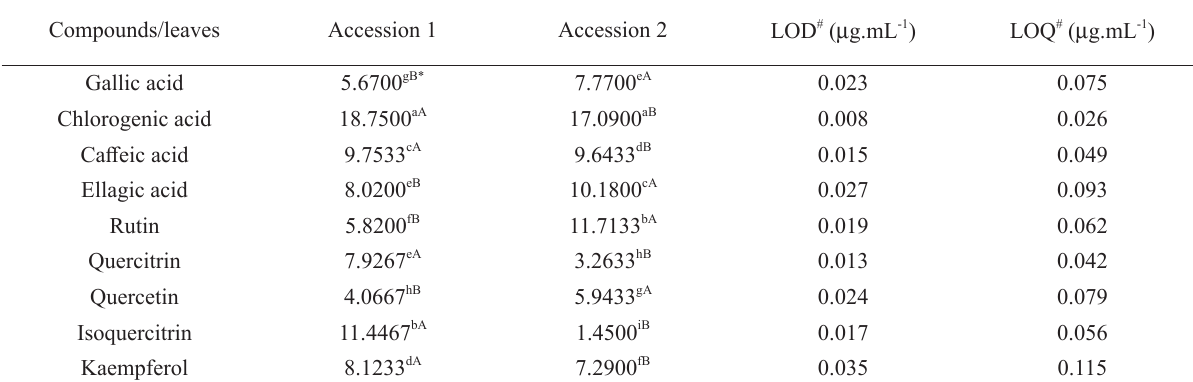
Phenolic compounds (mg/g) of aqueous extracts of the leaves of Sambucus australis in the concentration of 0.012 g/ml